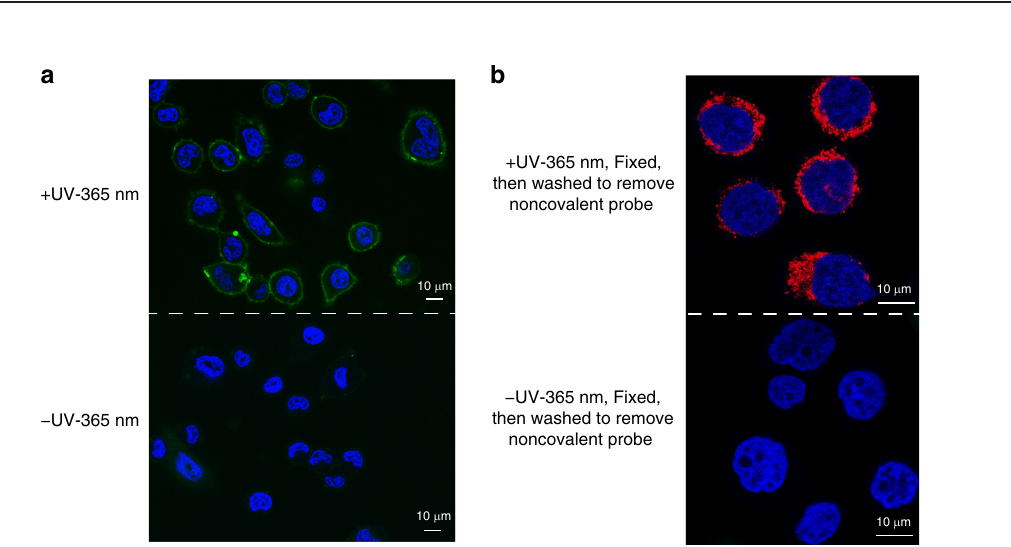
Fig. 6 Light-induced pro fi ling of endogenous kinases and mitochondria-targeted labeling in live cells. a Design of probe-1 targeting ATP binding site of kinase domain. Nitroso-probe-1 was photogenerated with temporal control. b Docking mode of STK24 kinase domain (PDB code:4QO9) with probe-1 (top), with photogenerated nitroso-probe-1 (bottom). c Venn diagrams showing the number of shared and unique kinases labeling with probe-1 from Jurkat cells and K562 cells, identi fi ed by LC – MS/MS after treatment of cells with probe-1. Captured protein kinases identi fi ed with ≥ 1 unique peptide, see Supplementary Information for details. d Schematic illustration of mitochondria-targeted temporal labeling via light-induced bioconjugation with fl uorescent Rho- o -NBA probe in living cells. e Confocal images of MDA-MB-468 cells stained with Rho- o -NBA probe (red channel), Rhodamine 123 (green channel), and Hoechst 33342 (blue channel) in different conditions: colocalization of Rho- o -NBA probe and Rhodamine 123 without light activation (top), colocalization of Rho- o -NBA probe, and Mito-EGFP reporter under light activation (bottom), without light activation see Supplementary Fig. 20b.